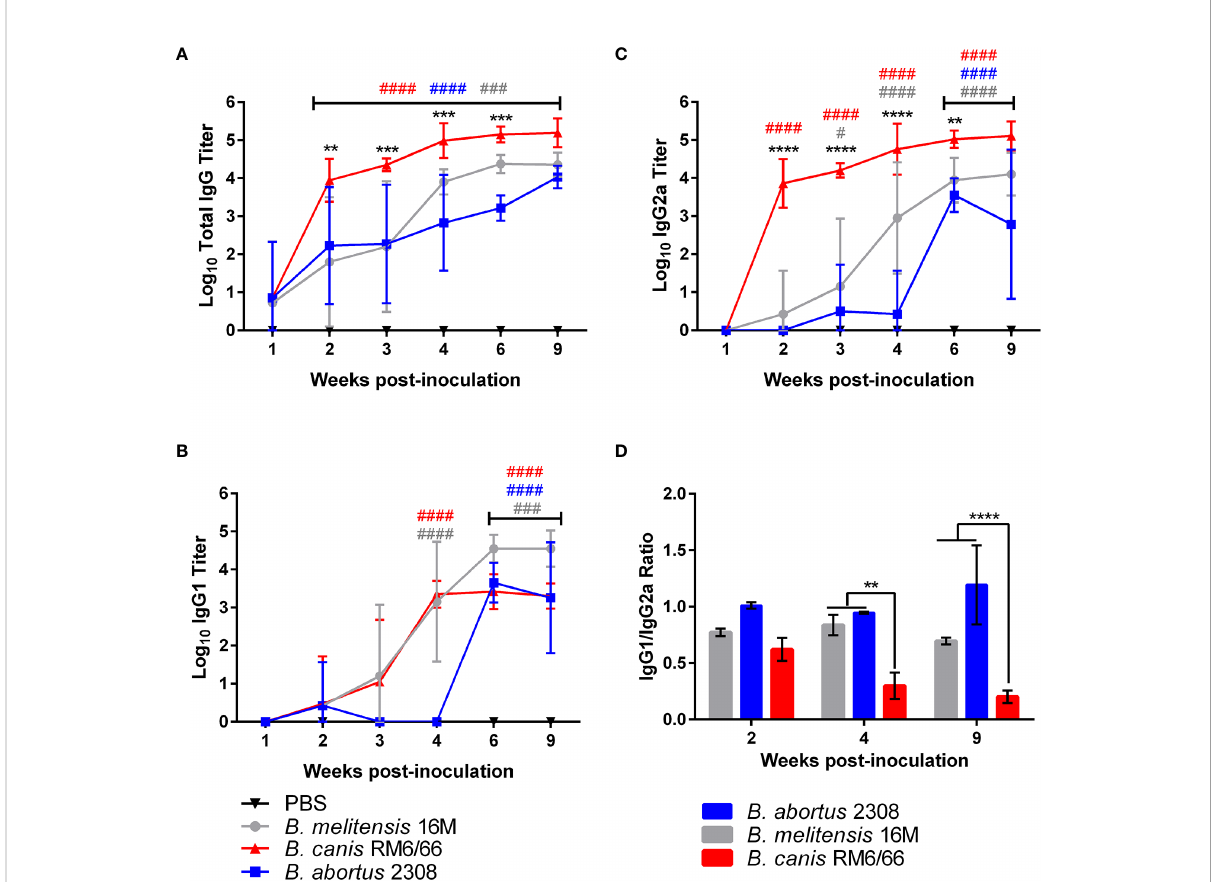
FIGURE 4 Brucella canis induces a stronger total anti- Brucella IgG response with a greater skew towards IgG2a. Brucella -speci fi c humoral immune response in mice inoculated intratracheally with B . canis, B. abortus , or B . melitensis . Sera was collected from weeks 1-4, 6- and 9-weeks post- inoculation for measurement of total IgG (A) , IgG1 (B) , and IgG2a (C) . Mean titers were compared between groups at each time point using two-way ANOVA and Tukey ’ s multiple comparisons test. Signi fi cant differences are depicted between B . canis and both B . abortus and B . melitensis (**p < 0.01, ***p < 0.001, ****p < 0.001) and between each infection group and the PBS negative control group (##p < 0.01, ###p < 0.001, ####p < 0.0001). (D) The ratio of IgG1:IgG2a was compared across infection groups. Signi fi cant differences are depicted between infection groups (**p < 0.01, ***p < 0.001, ****p <